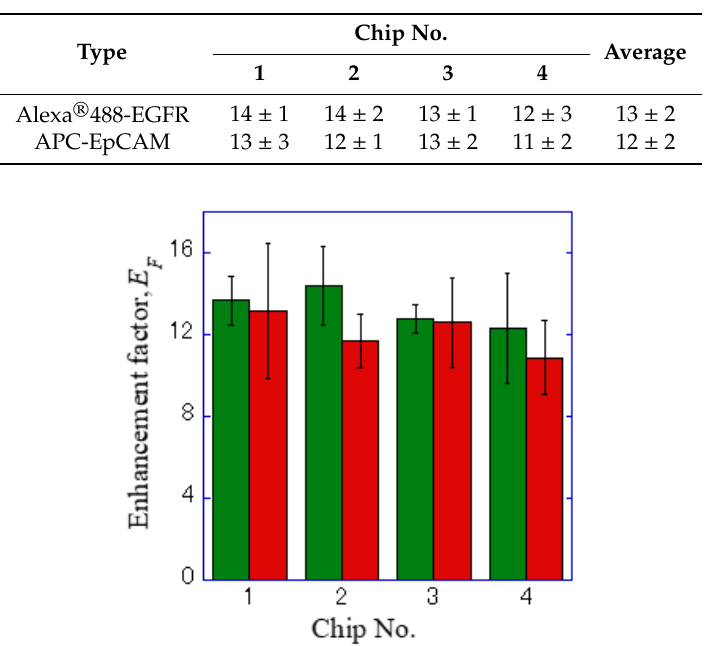
Figure 6. Enhancement factor for the four sheets of a plasmonic chip. The green and red bars correspond to the values for Alexa ® 488-EGFR and APC-EpCAM, respectively.